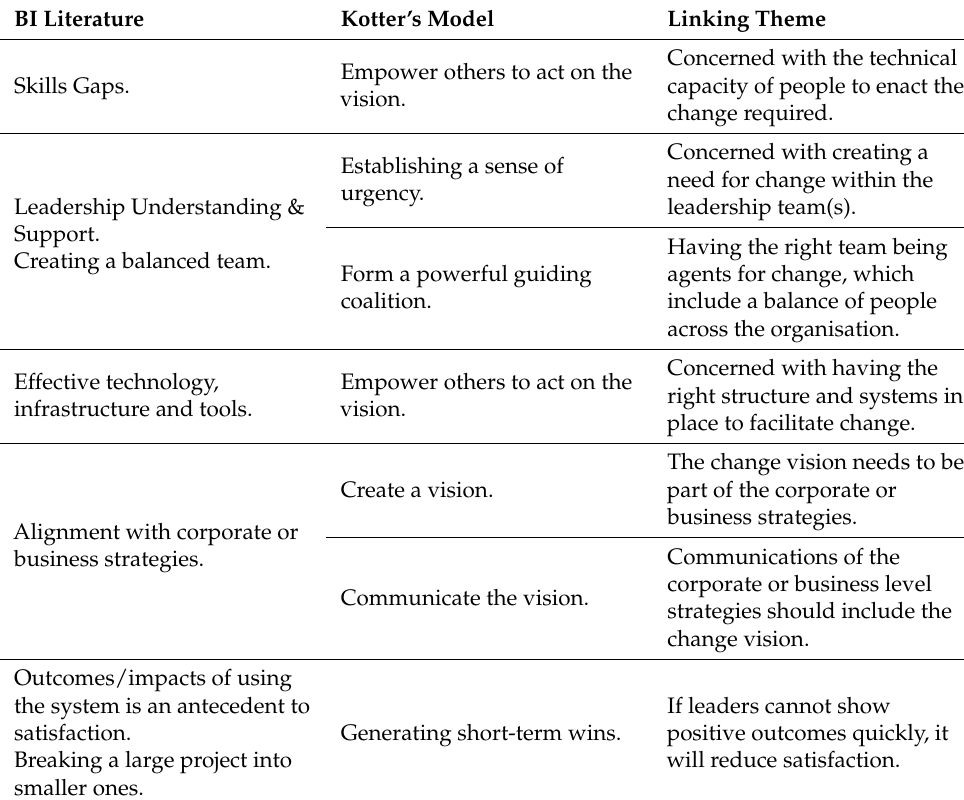
Table 1. BI and Kotter’s Change Model—developed for this